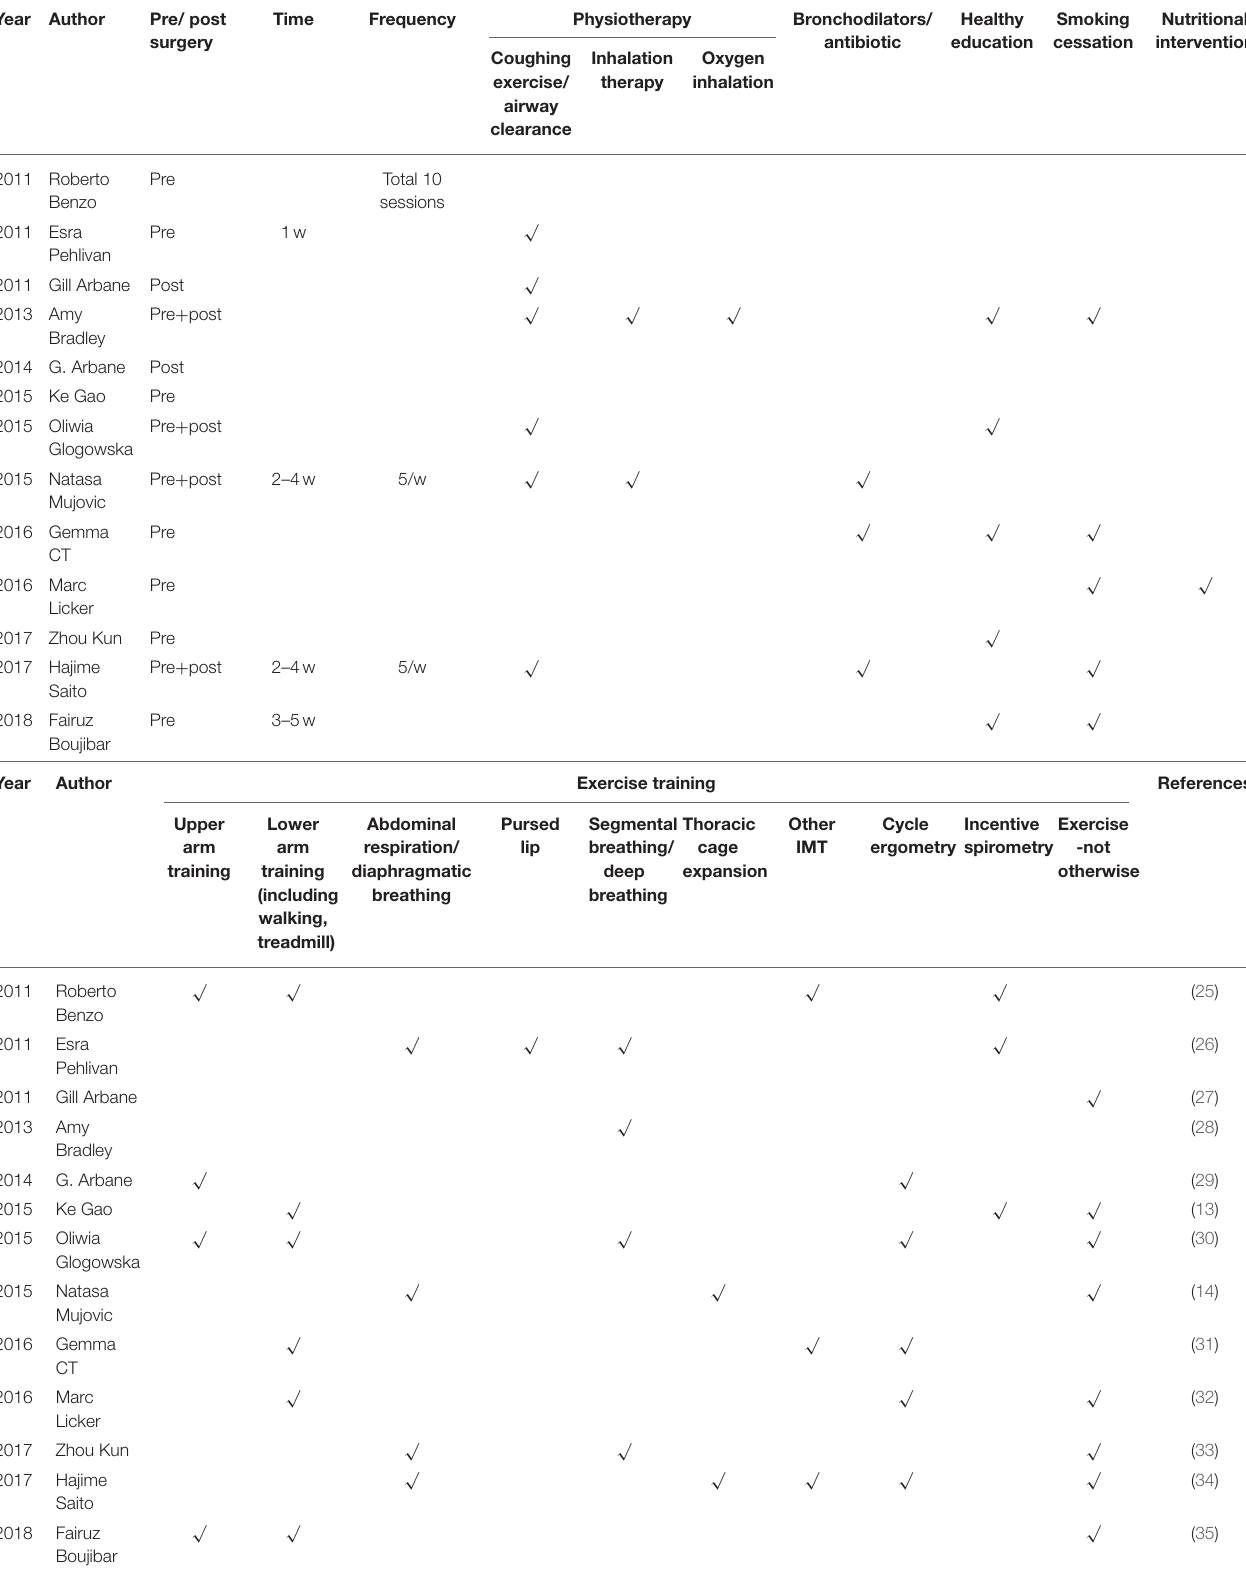
TABLE 2 | Pulmonary rehabilitation program of each